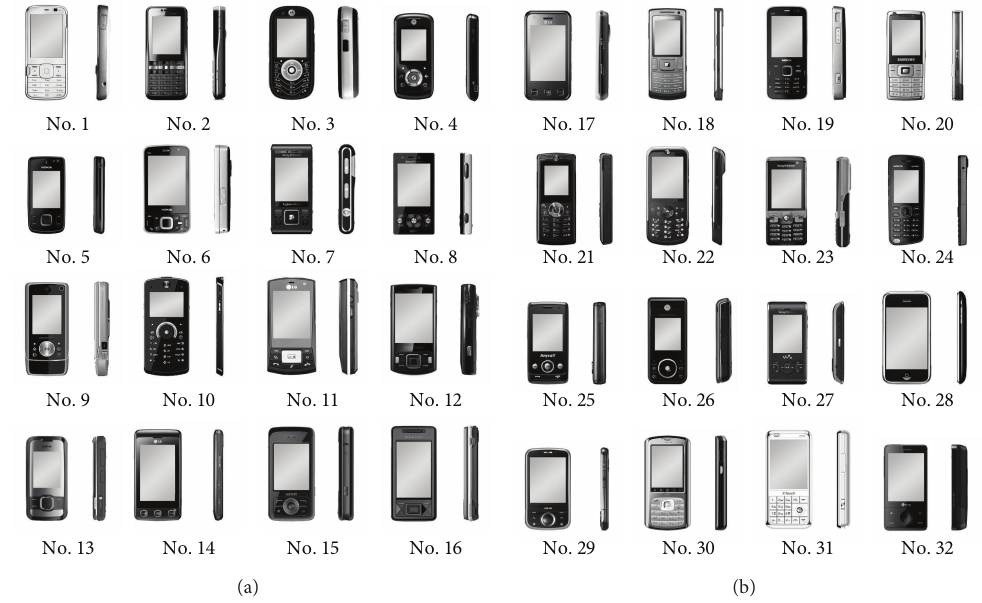
Figure 5: The 32 mobile phone image samples used in the case study.